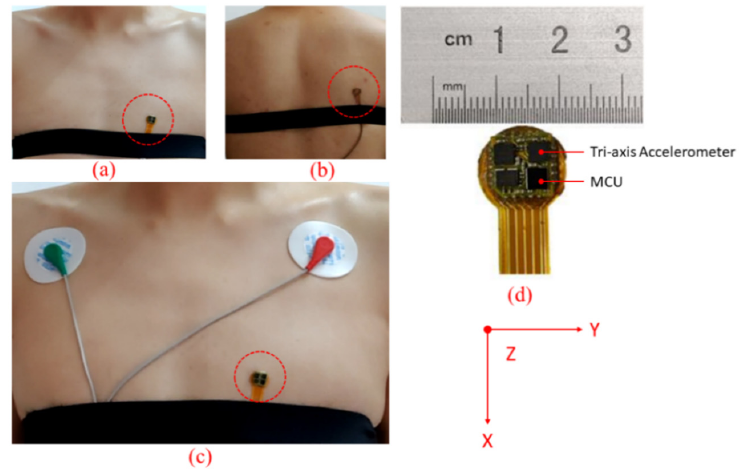
Figure 3. ( a , b ) Seismocardiography (SCG) recorder system placement for measuring heartbeat signal and motion signals, respectively. ( c ) A pair of electrocardiogram (ECG) lead I electrodes placement and SCG recorder system placement. ( d ) An image of the SCG recorder system which shows the dimensions. X ‐ axis, y ‐ axis and z ‐ axis describe the head to foot, shoulder to shoulder and dorsoventral direction, respectively.